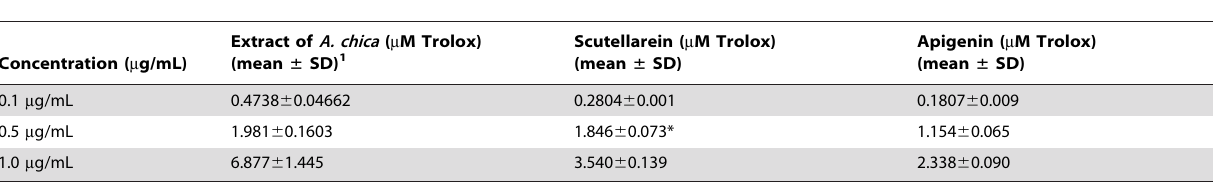
Table 7. Antioxidant activity of the extract of A. chica , scutellarein, and apigenin by TRAP ( m M Trolox).